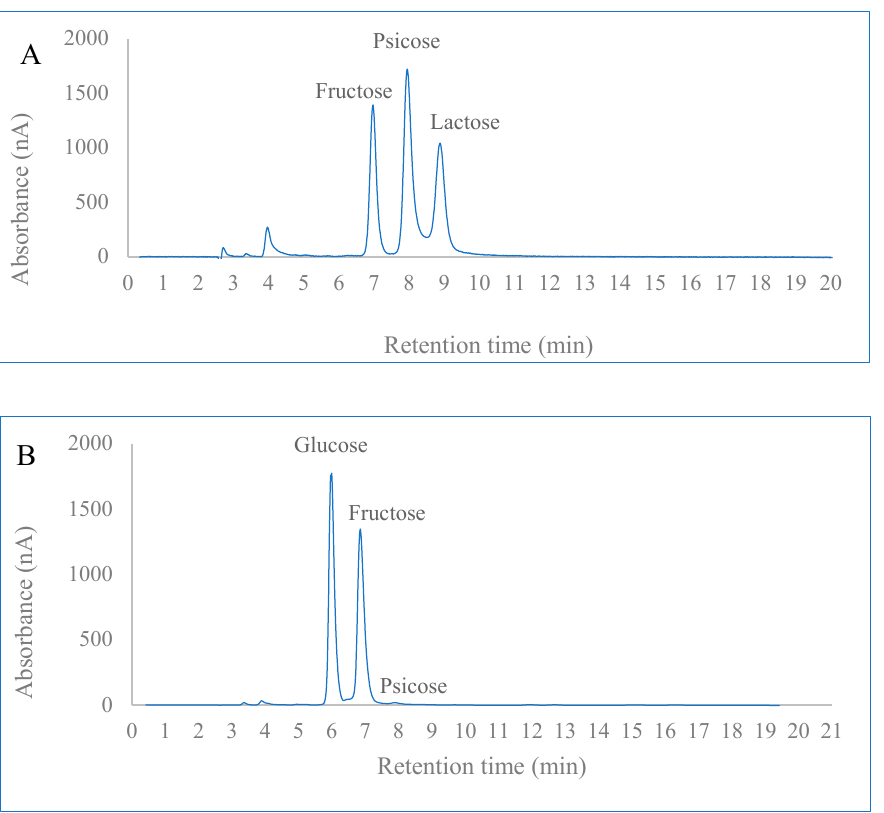
Figure 4. The representative chromatograms of a mixture of standard compounds (fructose–psicose–lactose) ( A ) and extract from raisins spiked with psicose standard ( B ).